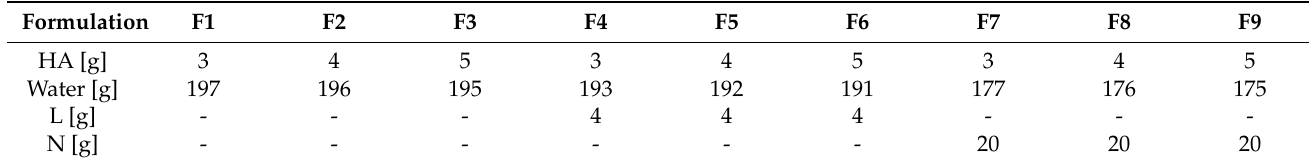
Figure 4. The viscosity of the formulations F1–F9 at the temperature of 37 °C. The ends of the horizontal lines show the compared formulations, that indicated statistically significant differences. The orange lines indicate the statistically significant differences arising from the L incorporation to formulations, the grey lines indicate the statistically significant differences arising from N incorpora- tion to formulations, the blue lines indicate the statistically significant differences resulting from the various concentration of carrier in formulations; n = 5, p < 0.05. Table 1. The composition of the obtained hydrogels.